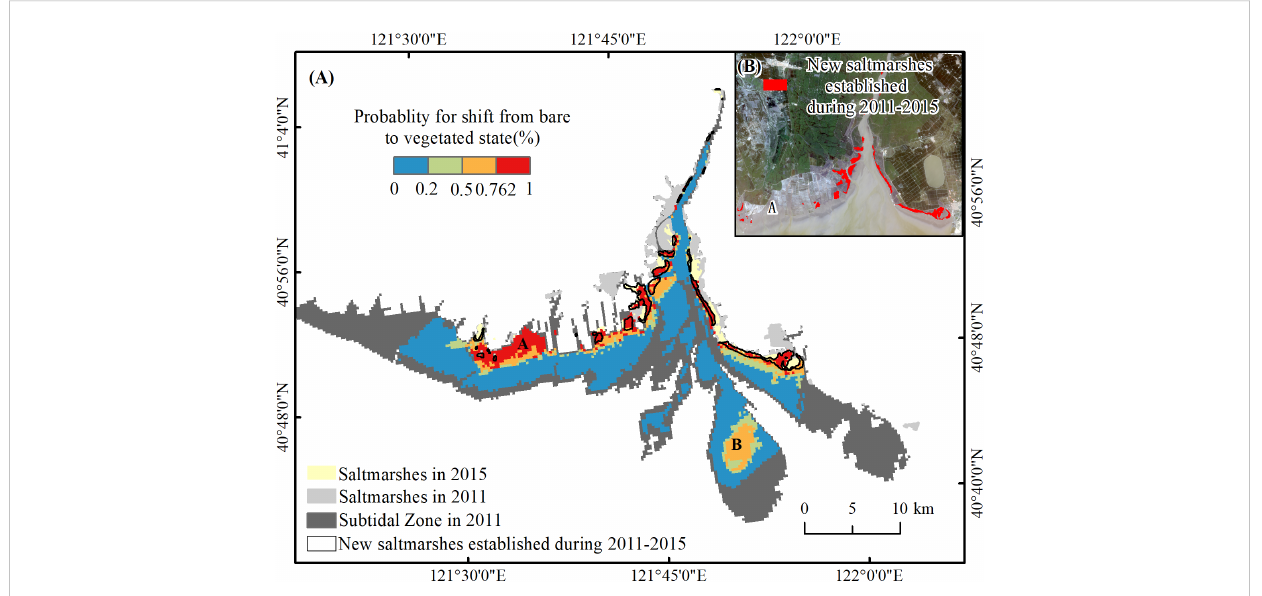
FIGURE 9 (A) Probability map for a shift from the bare to vegetated state based on the Logistic Regression Model 6. An incorrectly identi fi ed area of the new marsh was located in part A. (B) The newly established saltmarshes during 2011-2015 based on the interpretation of remote sensing images which are circled with a black hollow box in (A) .